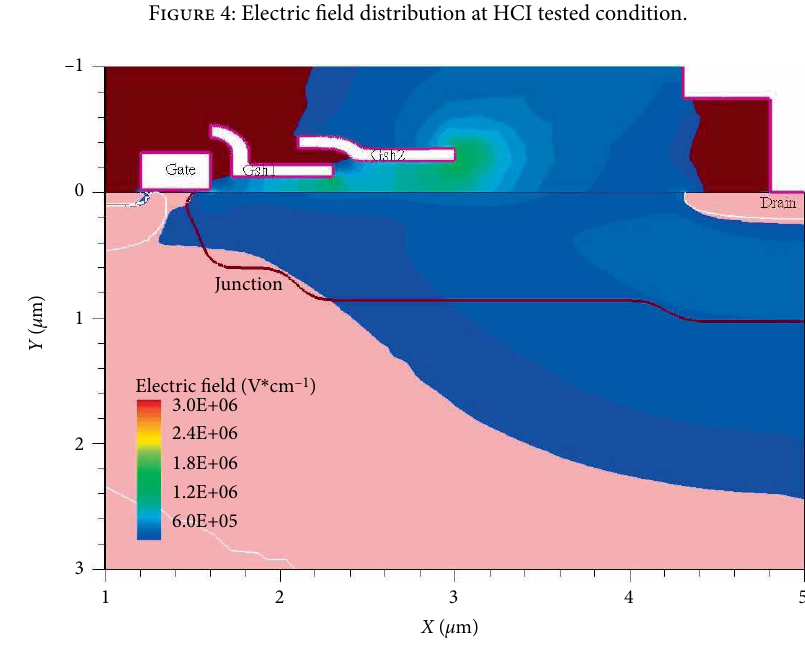
Figure 5: Electric field distribution at V